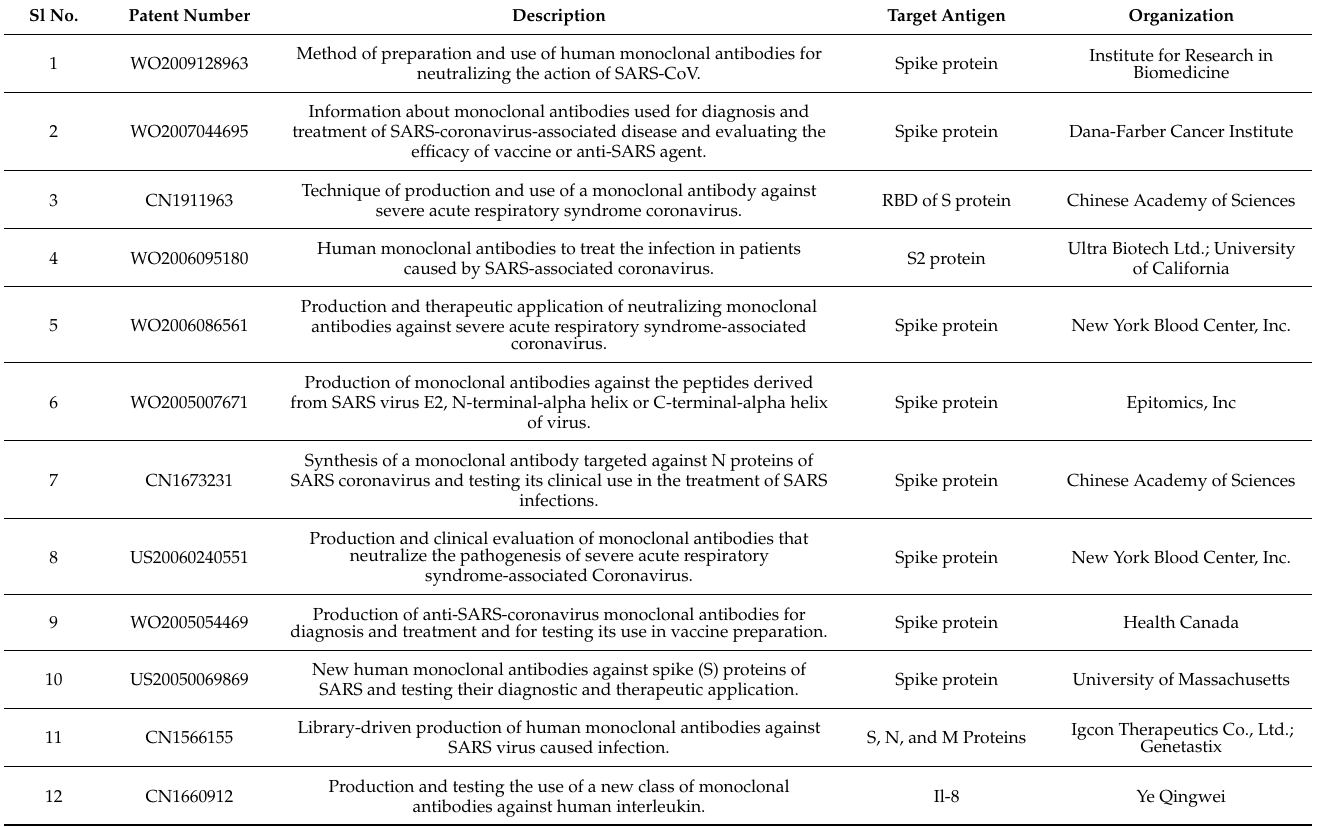
Table 3. Important MAb patents registered for treating COVID-19